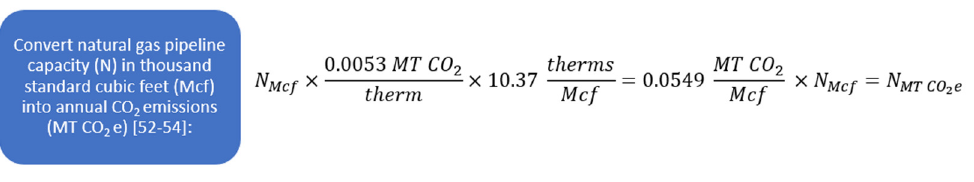
Figure 3. Equation used to calculate potential annual CO 2 emissions (MT CO 2 e) of a natural gas facility. It should be pointed out that the EPA GHG Equivalencies Calculator warns that due to rounding, calculations performed using the above equations may not return exact